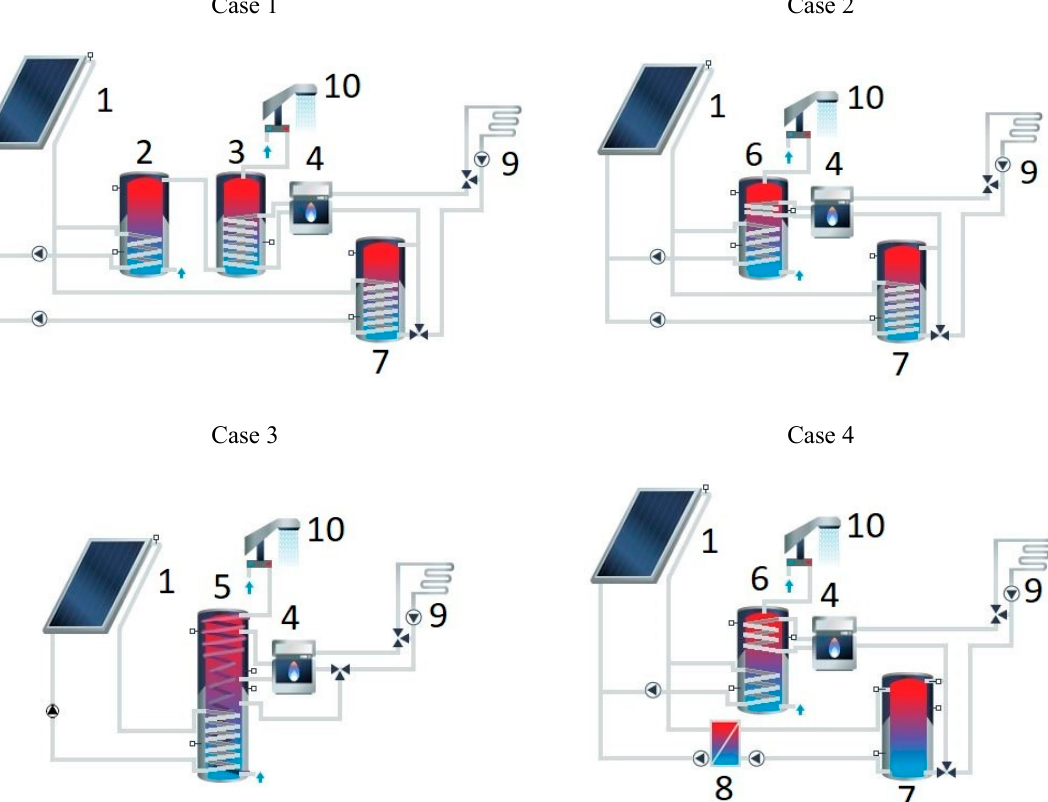
Figure 2. Cases 1, 2, 3, and 4. Numbers represent the following: 1—solar collector Thermosolar